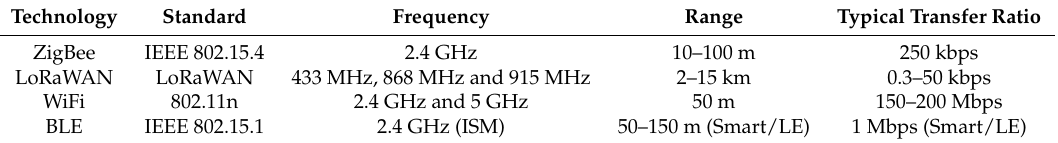
Table 1. Specifications of the studied wireless technologies.